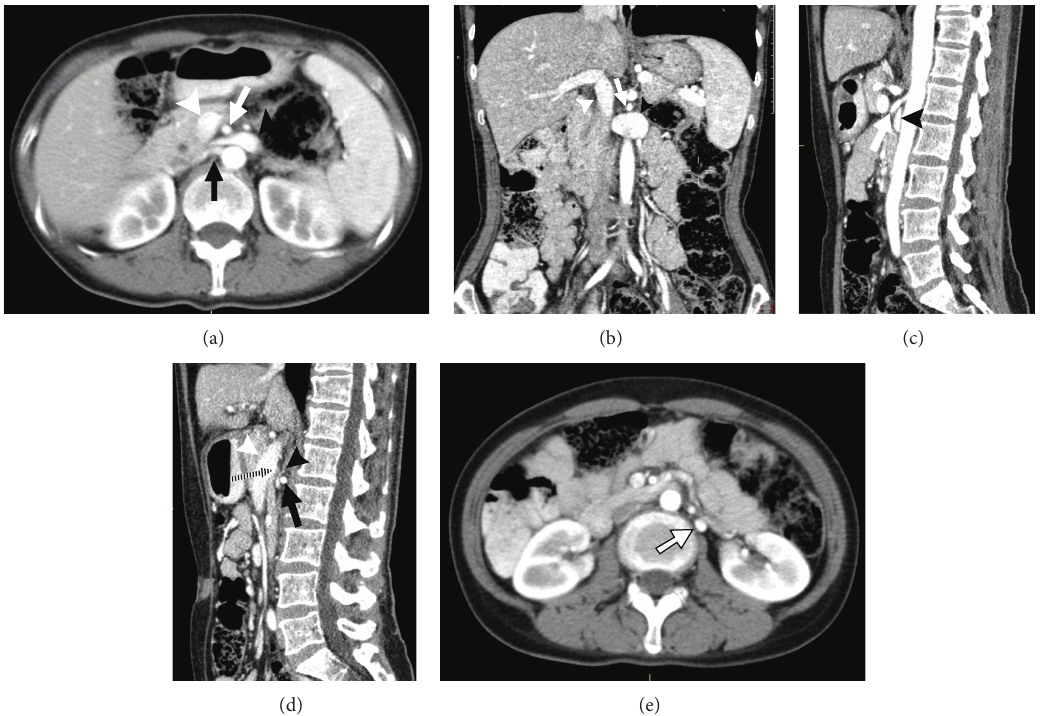
Figure 1: Multiplanar reconstruction of a nutcracker phenomenon. (a) Axial view: the left renal vein is compressed between the portal vein anteriorly and the right renal artery posteriorly. The left renal vein is patent after it traverses behind the superior mesenteric artery although minor compression occurs at this point. (b) Coronal view: the left renal vein ceases abruptly before the renocaval junction. (c) Sagittal view: the left renal vein is patent as it traverses behind the superior mesenteric artery. (d) Sagittal view: the left renal vein is compressed between the right renal artery and the portal vein. Adjacent retroperitoneal fat is present but not the offending structure. (e) Axial view: the left ovarian vein is dilated and enhancing, whilst the right ovarian vein is not appreciated. White arrowhead: portal vein; white arrow: superior mesenteric artery; black arrowhead: left renal vein; black arrow: right renal artery; white arrow with black border: left ovarian vein; black and white striped arrow: posterior bend of portal vein compressing left renal vein.